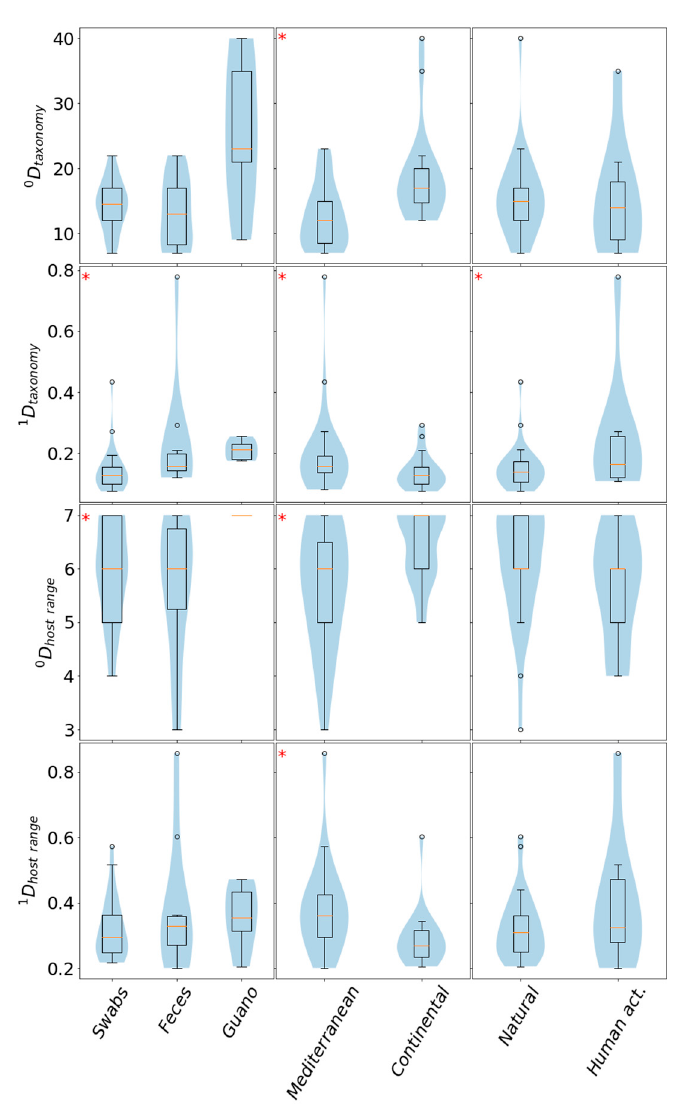
Figure 3. Taxonomy and host-range-based Hill diversity indices (D) calculated by grouping samples according to sample type (oral swab, feces, guano), geographical locations from where the samples were obtained (Mediterranean, continental) and whether the surrounding landscape is subject to human activity (Natural, Human act.). * denotes there may be statistically significant differences ( p < 0.01) between the population medians of the strata, based on the Kruskal–Wallis test. The diversity indices are depicted a violin plots, widths of the “violins” correspond to the kernel density estimates at the given ordinate, and as box and whisker plots, indicating the data mean (orange line), the box stretches between the first (Q1) and the third quartile (Q3), and the whiskers enveloping the most extreme values lower than Q1 or higher than Q3 by more than 1.5 * (Q3-Q1); values beyond the whisker definition are depicted as individual circles/points.